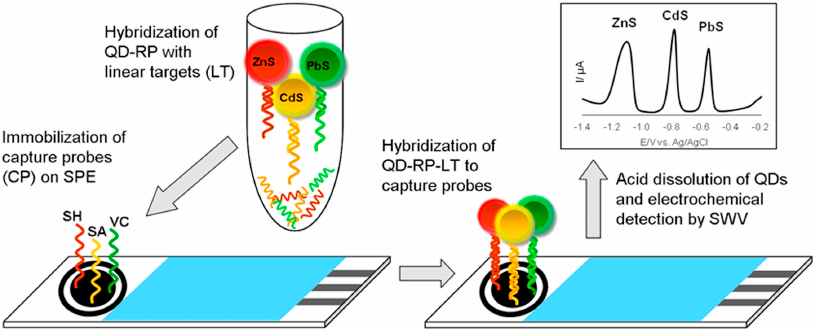
Figure 8. Schematic illustration of sandwich DNA hybridization assay for simultaneous determination of the three pathogens using PbS, CdS, and ZnS QDs. Reproduced from [67], with permission from Elsevier, 2019.